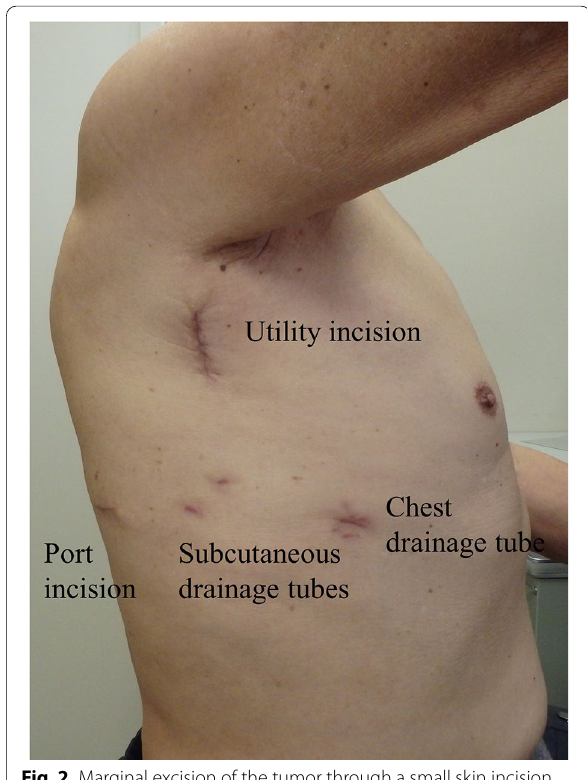
Fig. 2 Marginal excision of the tumor through a small skin incision with videoscopic assistance